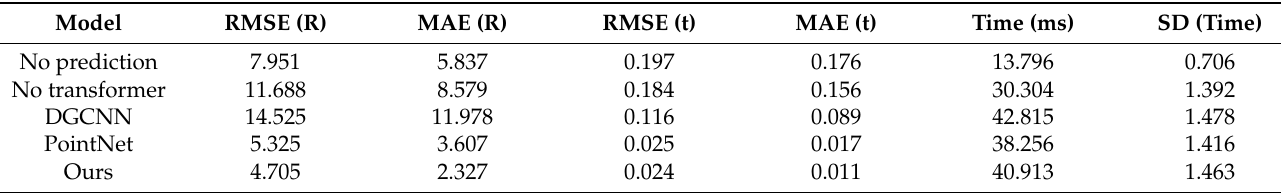
Table 4. Results of ablation study.